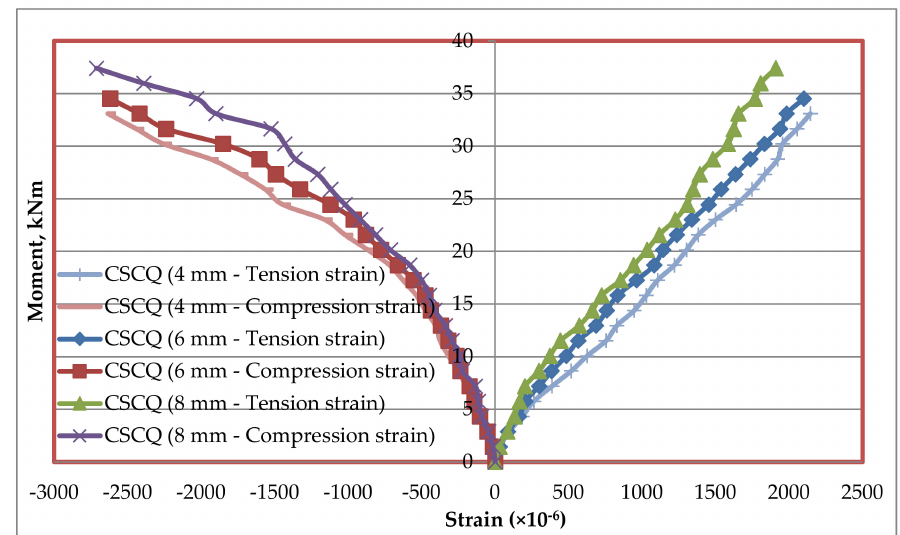
Figure 22. Strain distribution of SCS beams used with CSCQ mix.